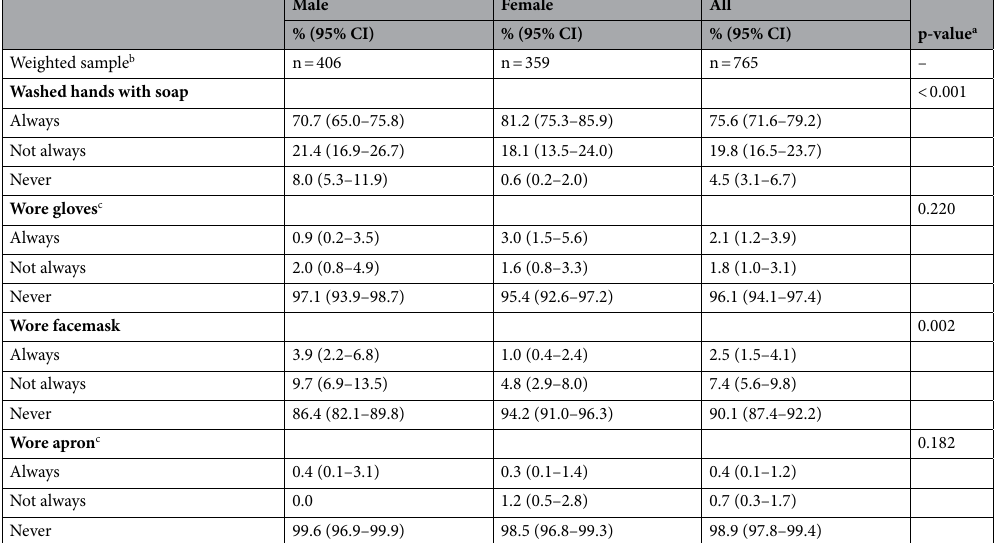
Table 3. Uptake of protective practices among those with poultry exposure in the past year, by sex, Dhaka City Corporation, Bangladesh. CI confidence interval. a P-value obtained from chi-square test comparing males and females. b Sample weighted by age, sex and education to the Dhaka City Corporation demographic profile of the 2011 Bangladesh census. Weighted denominator is those who report any exposure to live poultry in the past year. c Question was only asked to those who report slaughtering, defeathering, eviscerating and/or cutting poultry; weighted denominator includes only those who report these exposures, n =